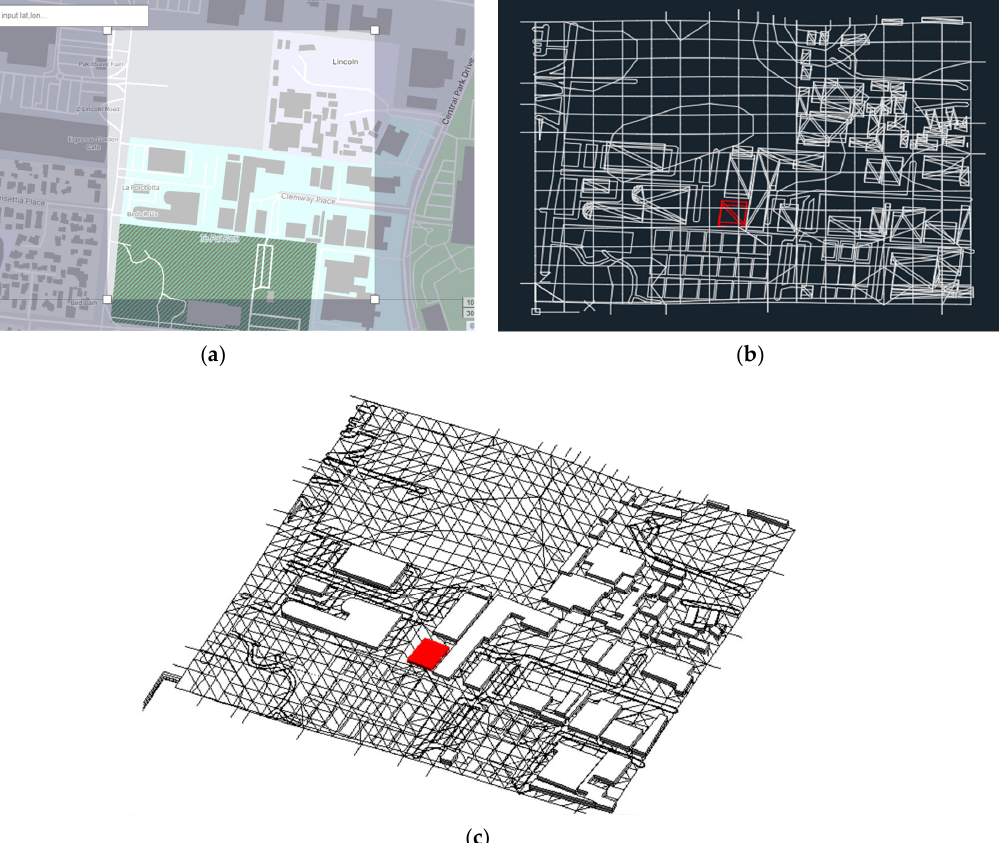
Figure 2. Mapping the in-use steel products procedures for the case building in Auckland (201 Lincoln Drive Henderson): ( a ) Capturing the selected area by GeoMaps; ( b ) Importing regional map into AutoCAD; ( c ) BIM modelling of investigated building.